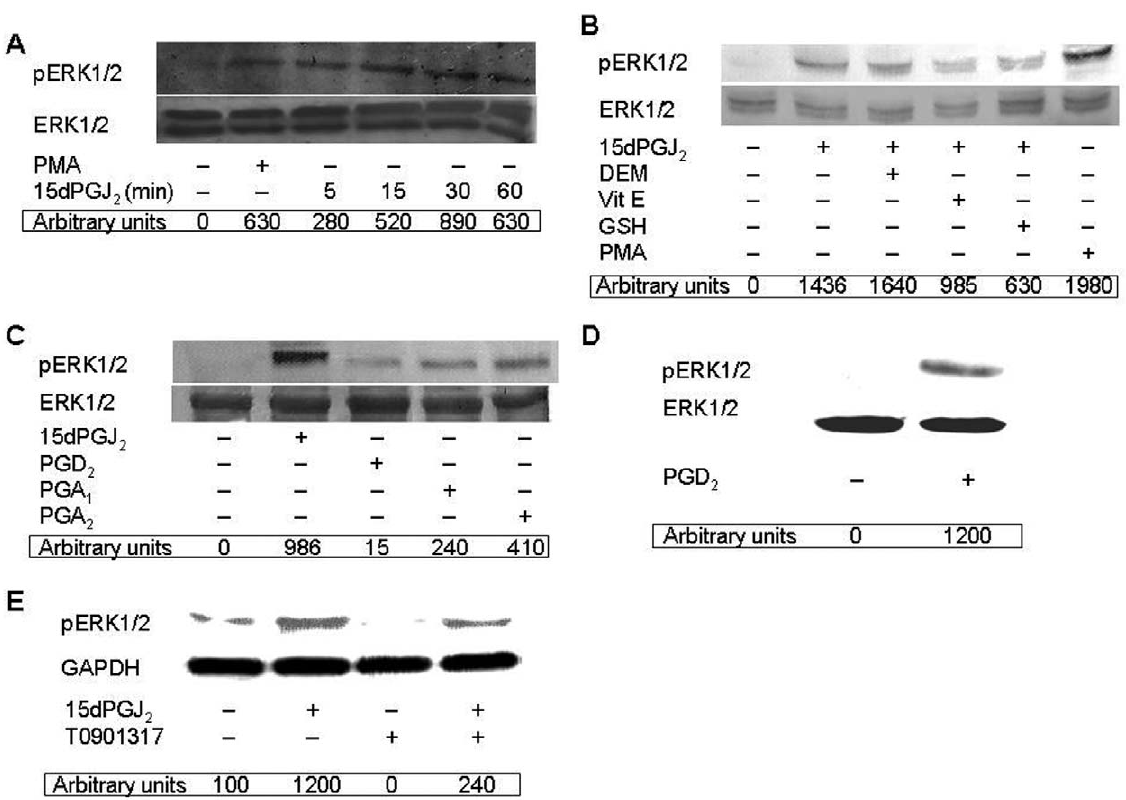
Figure 6. 15dPGJ 2 -promoted ERK1/2 phosphorylation is dependent on oxidative stress in human neutrophils. Neutrophils were preincubated at 37 u C with or without 10 m M DEM, 100 m M Vit E or 1 mM GSH for 1 h (B). Then the cells were treated or not with 10 m M 15dPGJ 2 for the indicated times (A) or for 30 min (B, C and E), and then with 100 nM PMA for 7 min (A and B), or else with 10 m M PGD 2 , 15 m M PGA 1 or 25 m M PGA 2 for 30 min (C), with 10 m M PGD 2 for 20 h (D), or with 1 m M T0901317 for 30 min (E). Phosphorylated ERK1/2 (pERK1/2) levels were analyzed on cell lysates by Western blotting and are given in arbitrary units. Immunoblots of total ERK1/2 (A-D) or GAPDH (E) are also shown for the sake of loading controls. Each blot is representative of a set of three separate experiments yielding similar results.